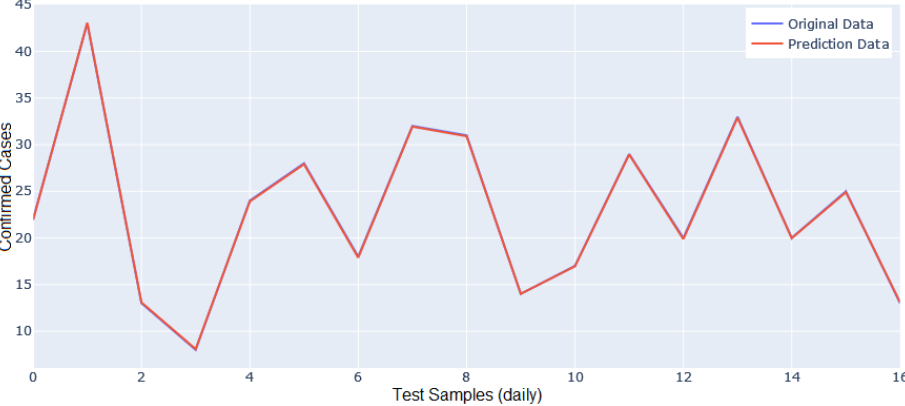
Figure 12. Comparison between actual and predicted data using the AQIoT-4 test